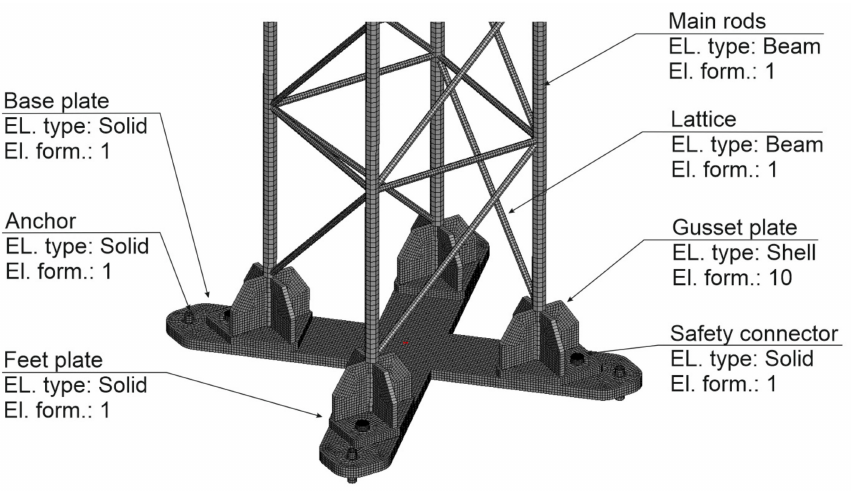
Figure 6. Numerical model of T03